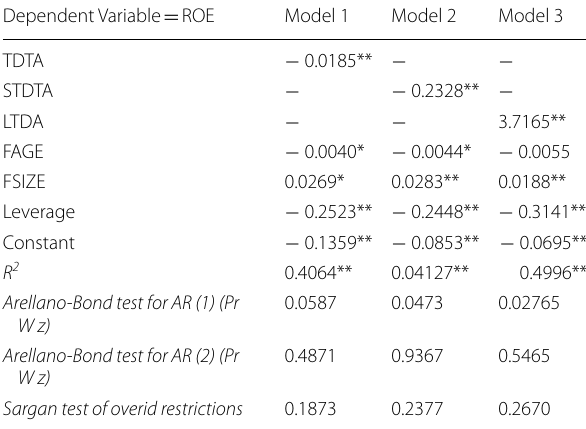
*Indicates Significance level 0.05 and ** Indicates Significance level